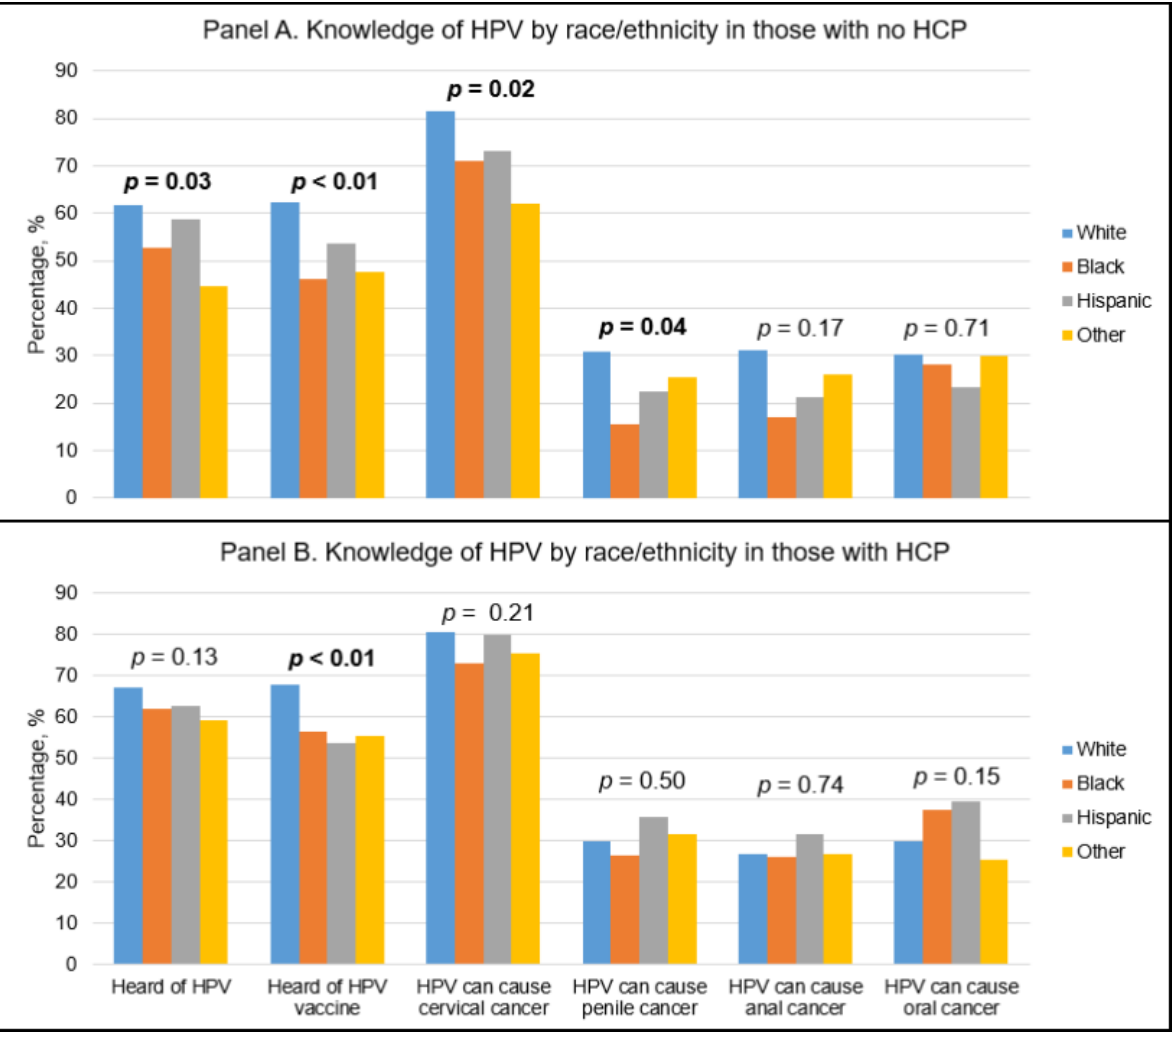
Figure 1. HPV awareness by racial/ethnic group stratified on HCP status; p -values denote differences between racial/ethnic groups (White, Black, Hispanic, and Other).